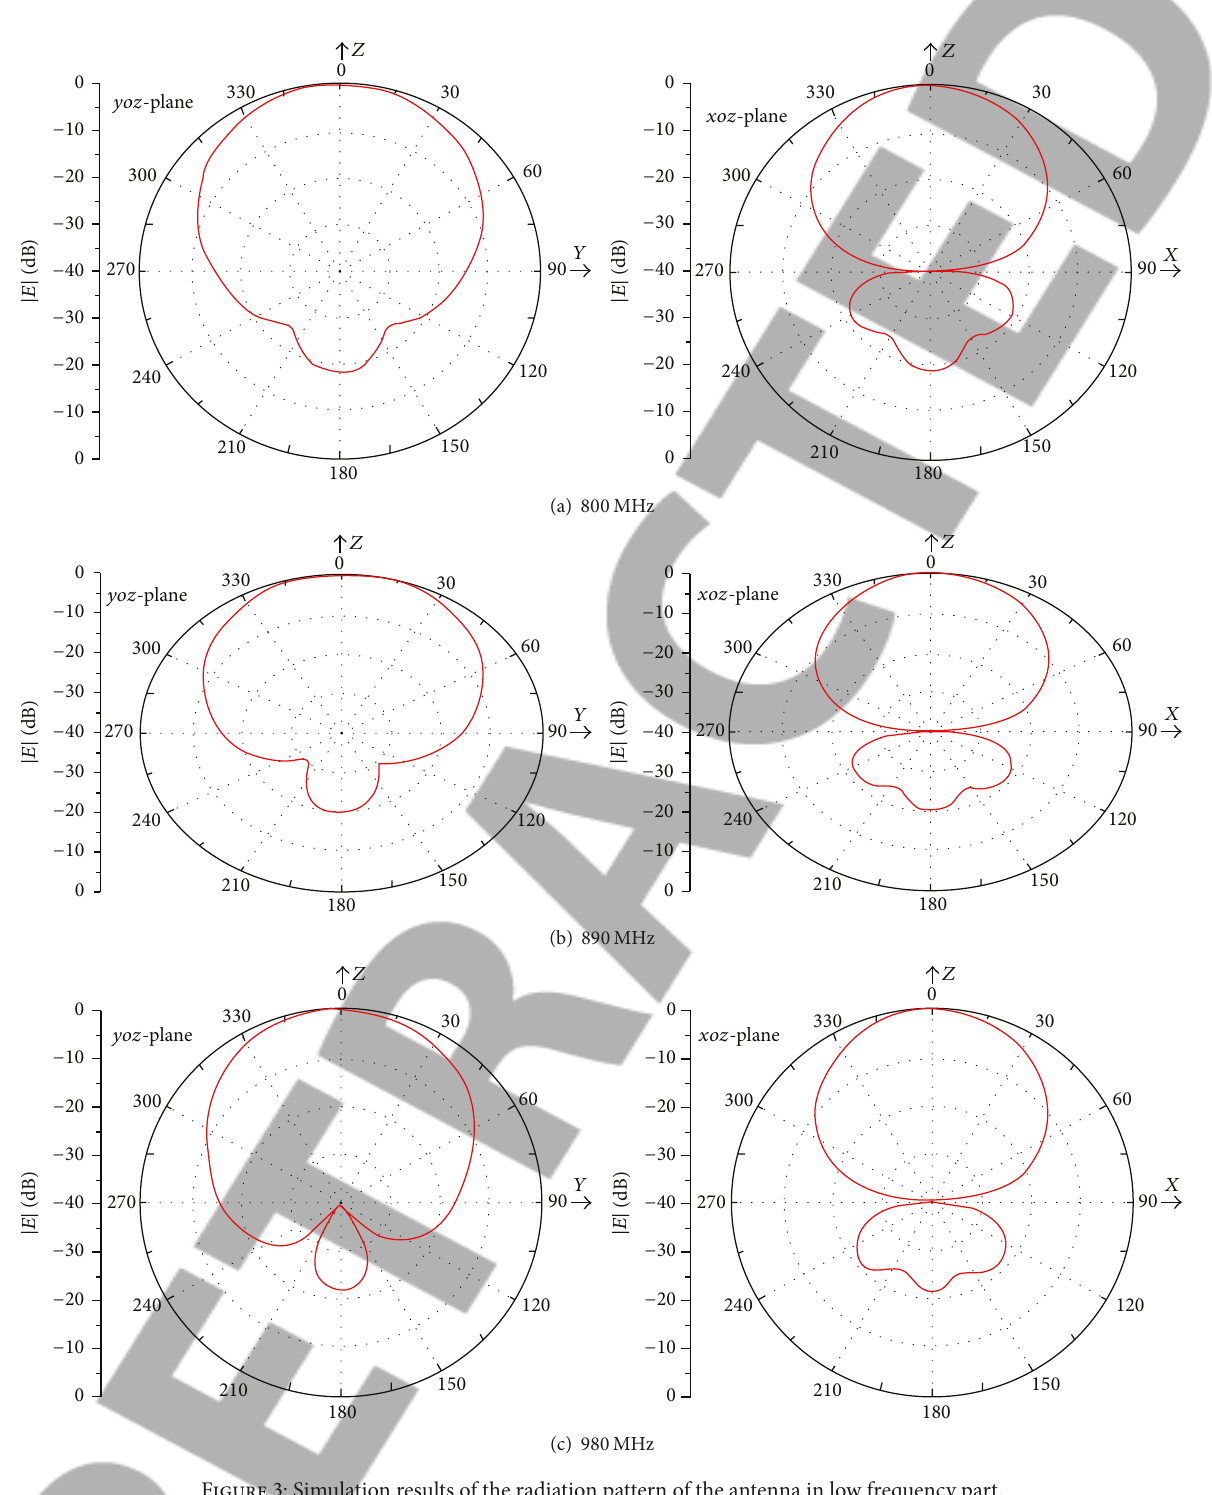
Figure 3: Simulation results of the radiation pattern of the antenna in low frequency